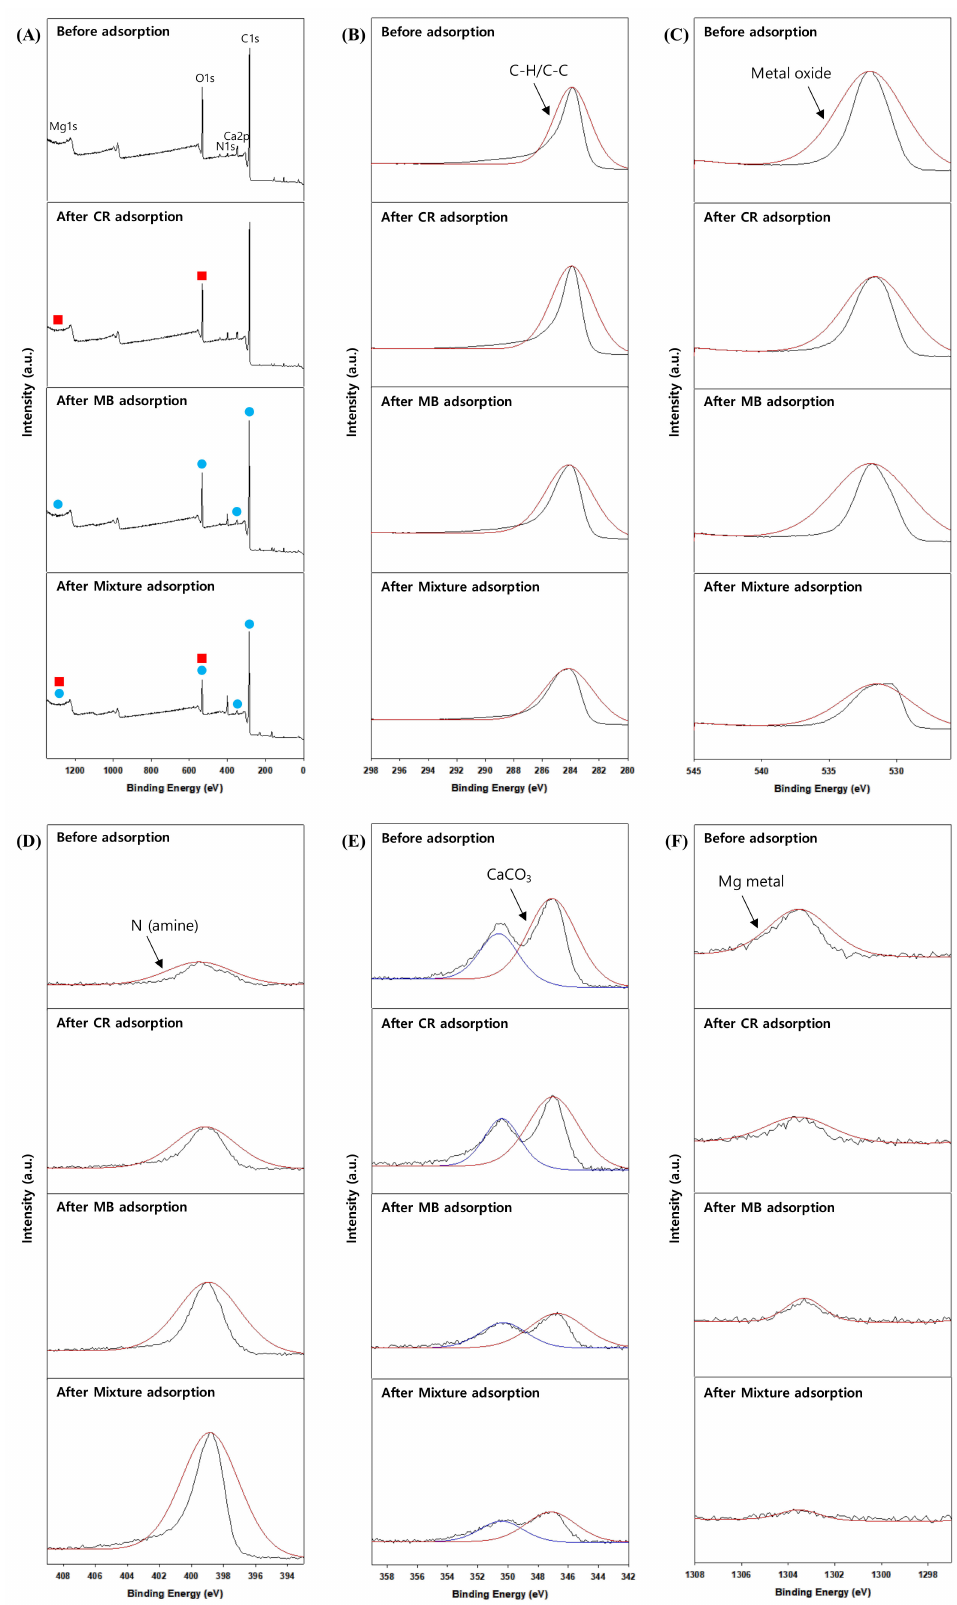
Figure 5. XPS of ( A ) survey scan, ( B ) C1s, ( C ) O1s, ( D ) N1s, ( E ) Ca2p, and ( F ) Mg1s of BC550 before and after adsorption